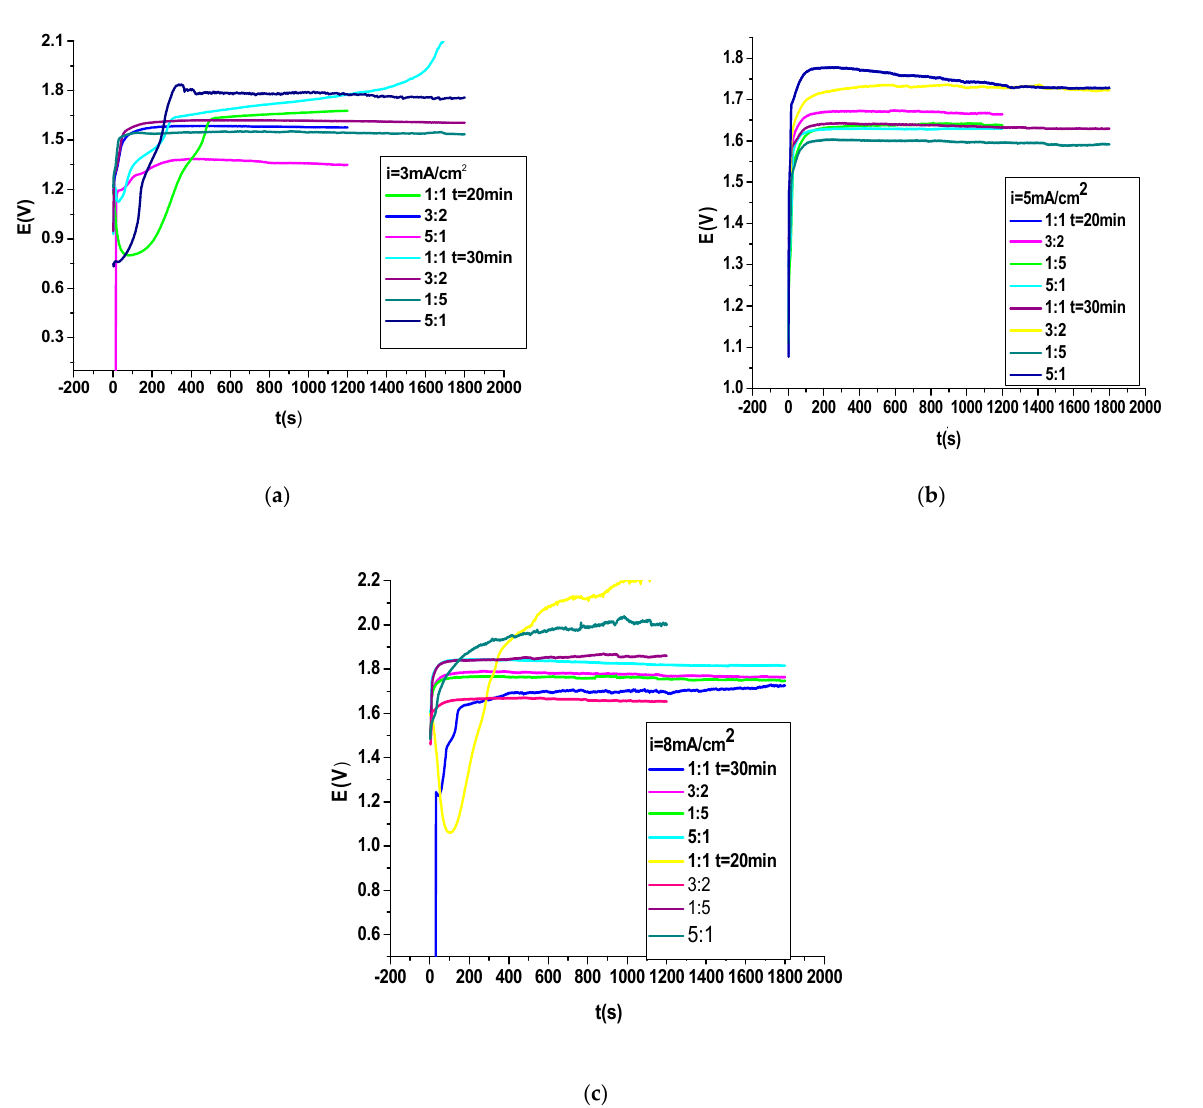
Figure 2. Galvanostatic method for obtaining of PNPY-TRX100/PNNDEA/OL 37 at current densities ( a ) 3 mA/cm 2 , ( b ) at 5 mA/cm 2 and ( c ) at 8 mA/cm 2 ) and permitted for 20 min and 30 min at varied molar ratios for PNMPY-TRX100 and PNNDEA.